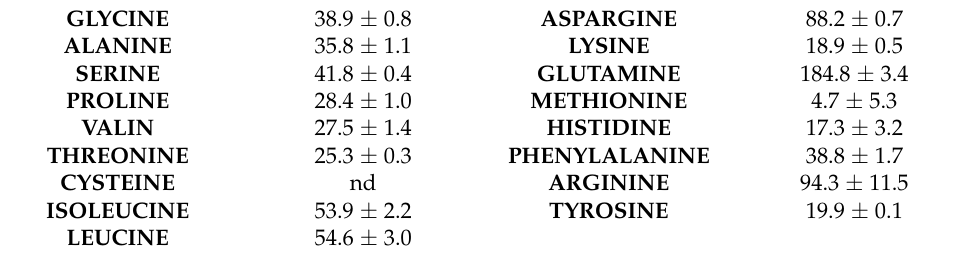
Table 2. Amino acid profile of hazelnut meal protein isolate (mg/g protein).